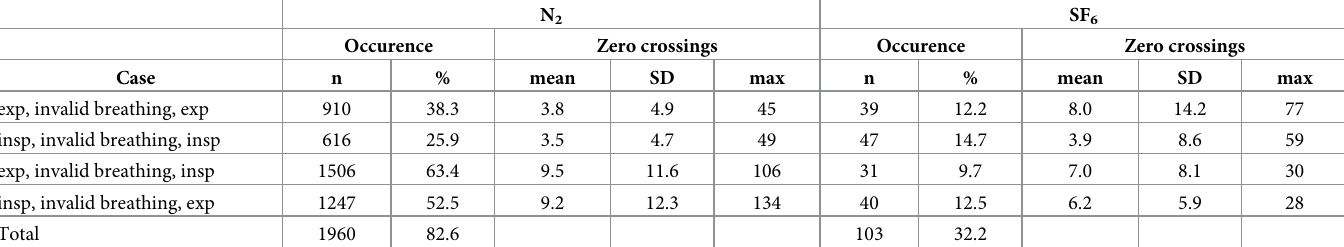
Table 3. Rejected data by Spiroware software. Occurrence: number of rejected sections per trial; zero crossings: number of affected zero crossings per trial; exp: expira- tion; insp: